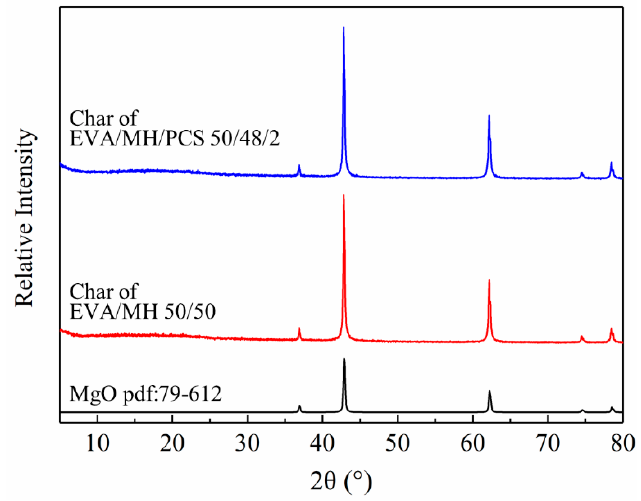
Figure 10. XRD patterns of MgO and the residual char of EVA/MH and